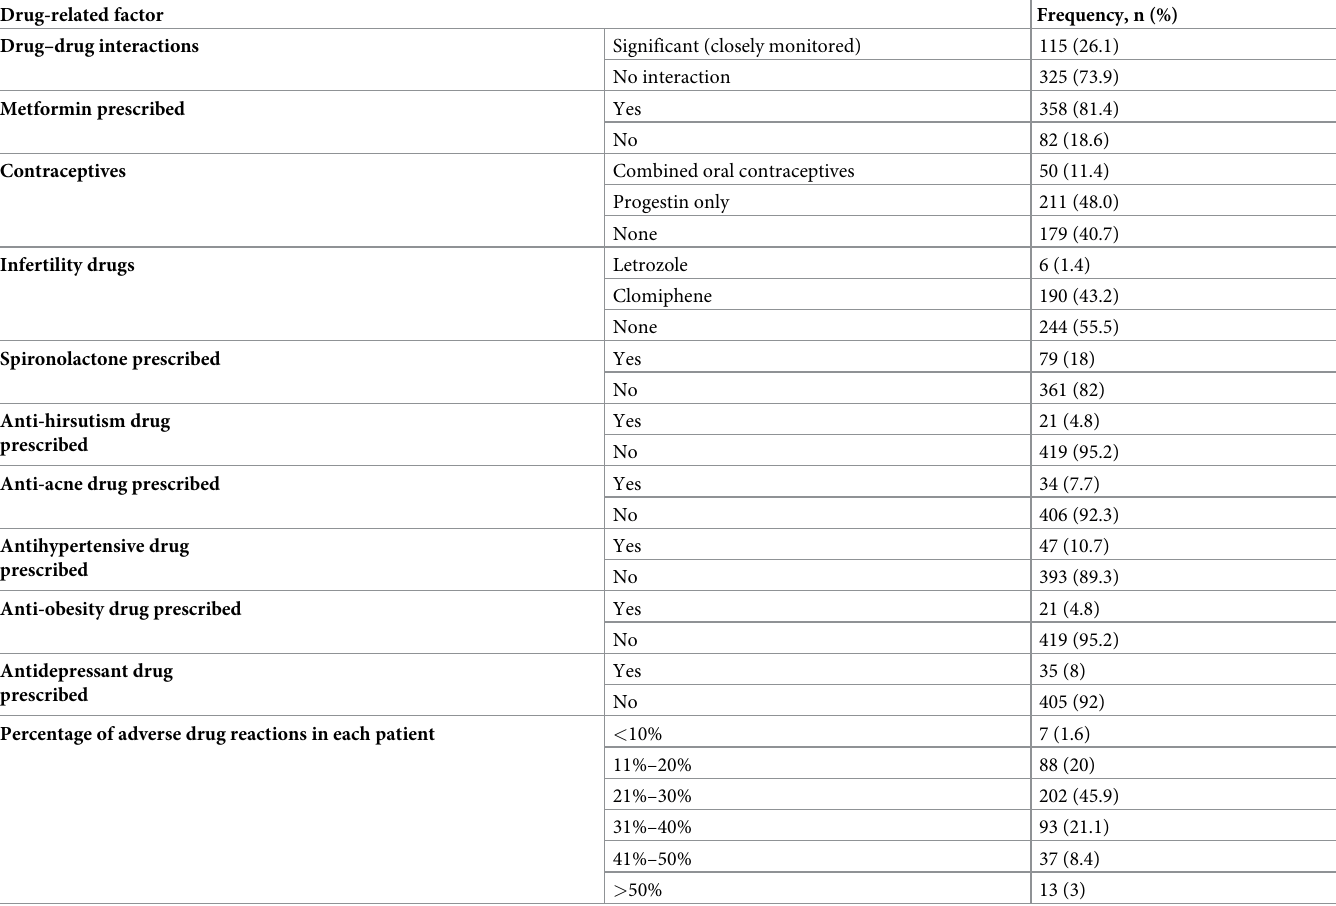
Table 3. Drug-related factors in patients with